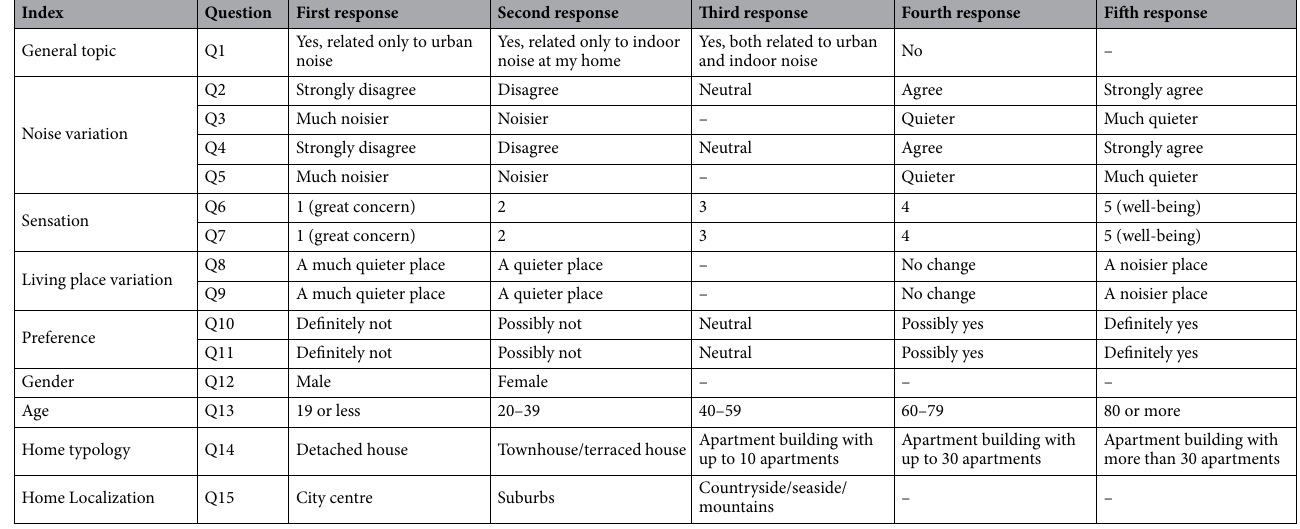
Table 2. Survey possible choices per